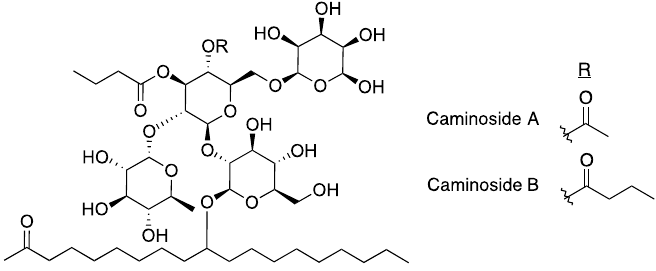
Figure 3. Structures of caminosides, inhibitors isolated from marine sponge C. sphaeroconia .